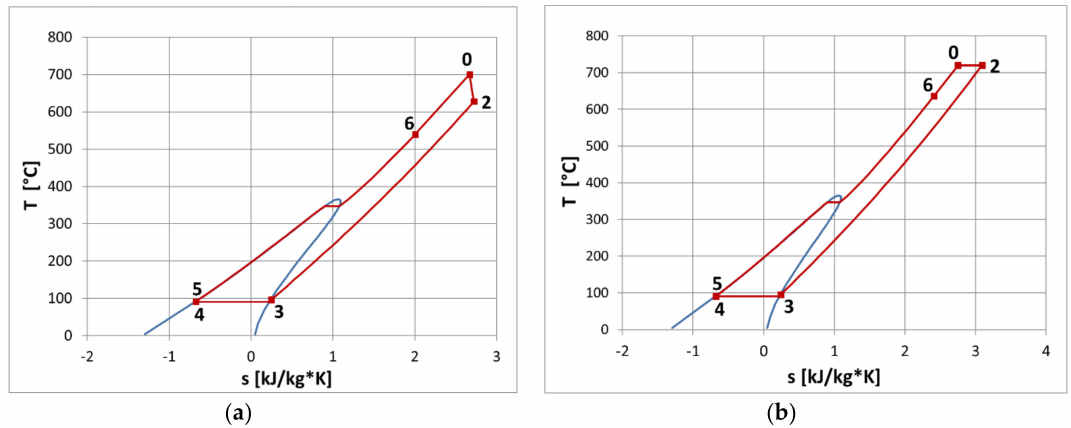
Figure 4. Interpretation of Variant 2 for adiabatic ( a ) and isothermal ( b ) expansion (working medium: undecane-C11); where: limit line—red and cycle—blue